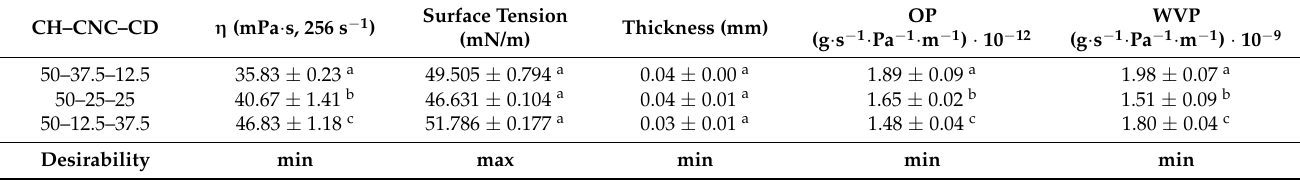
Table 5. Properties of CH–CNC–CD solutions and CH–CNC–CD final formed edible films.